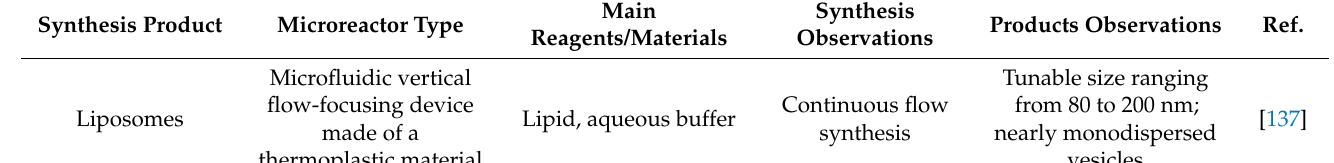
Table 4. Summary of organic nanomaterials synthesized via microfluidic